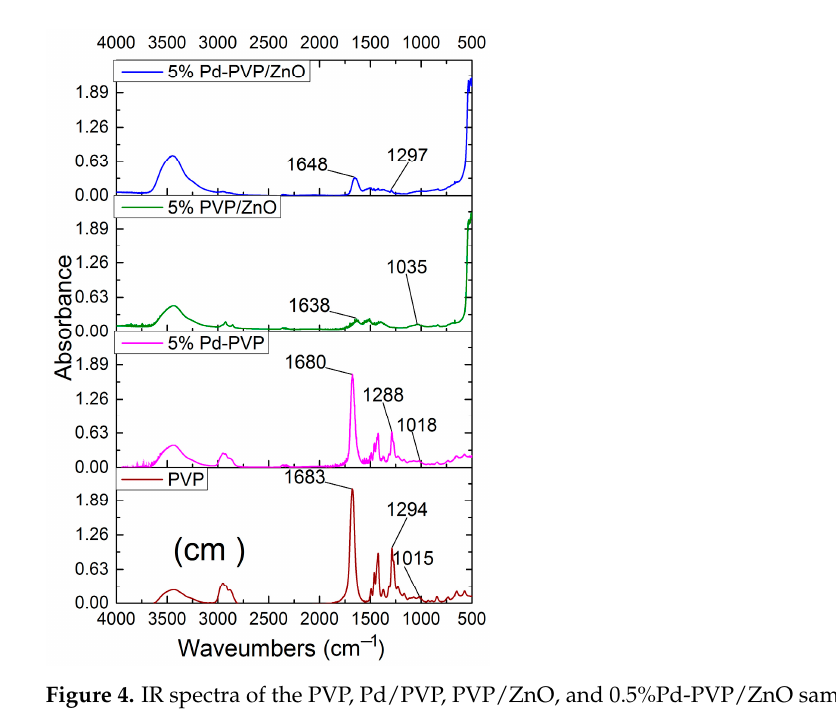
Figure 4. IR spectra of the PVP, Pd/PVP, PVP/ZnO, and 0.5%Pd-PVP/ZnO samples.